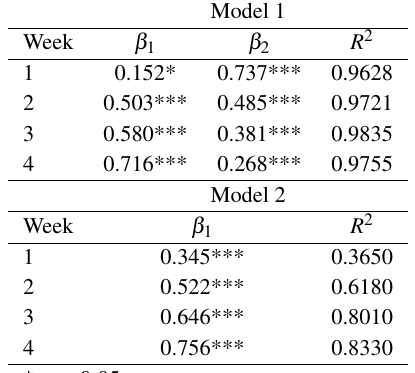
Table 3: Experiment 2: Multiple linear correlation coefficients showing the dependence of the post-trading belief as a function of the pre-trading belief and the market prices, according to the formula Belief post = β 0 + β 1 Belief pre + β 2 Market (Model 1), and coefficients of the linear regression according to the formula Belief post = β 0 + β 1 ( Belief pre − Market ) (Model